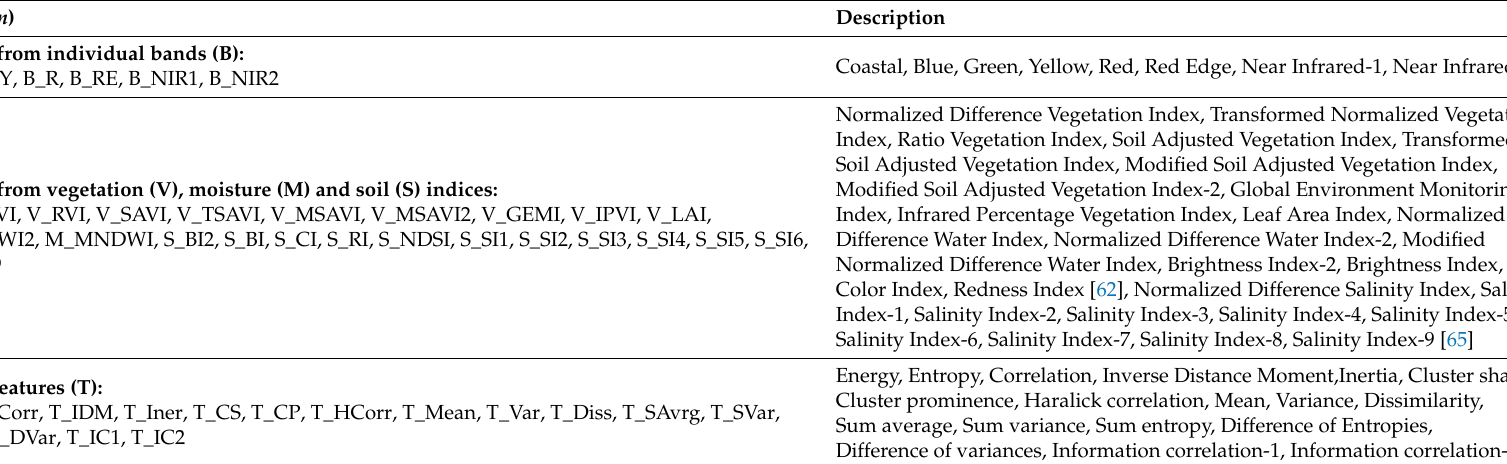
Table 3. Initial image features serving as potential